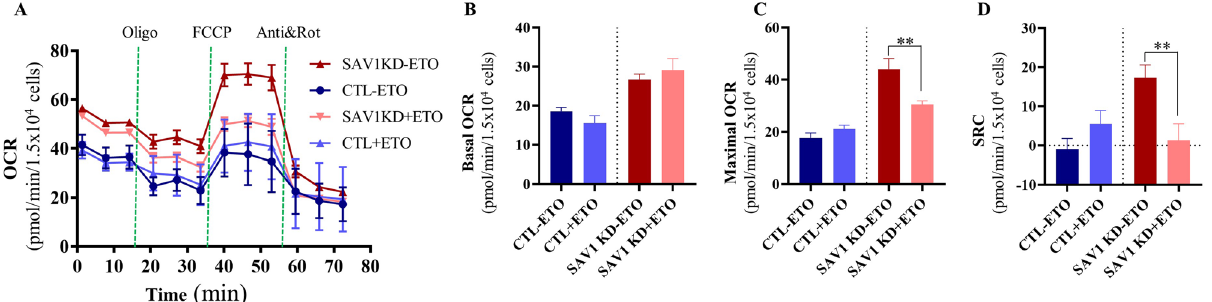
Figure 8. SAV1 KD cells had enhanced ability to oxidize endogenous fatty acid under limited glucose with bovine serum albumin. ( A ) Representative traces of real-time OCR measurements in both SAV1 KD and CTL cells showing the basal respiration and OCR changes in response to sequential injections of inhibitors for mitochondrial oxidative phosphorylation. ( B ) Under lower substrate demand, basal OCR was similar in CTL cells with or without ETO treatment. Similarly, no difference was seen in basal OCR in SAV1 KD cells with or without ETO treatment. ( C ) After being bioenergetically stressed with FCCP to increase